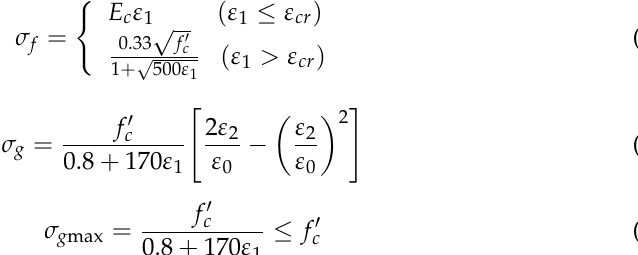
Figure 6. Mean strain Mohr circle.